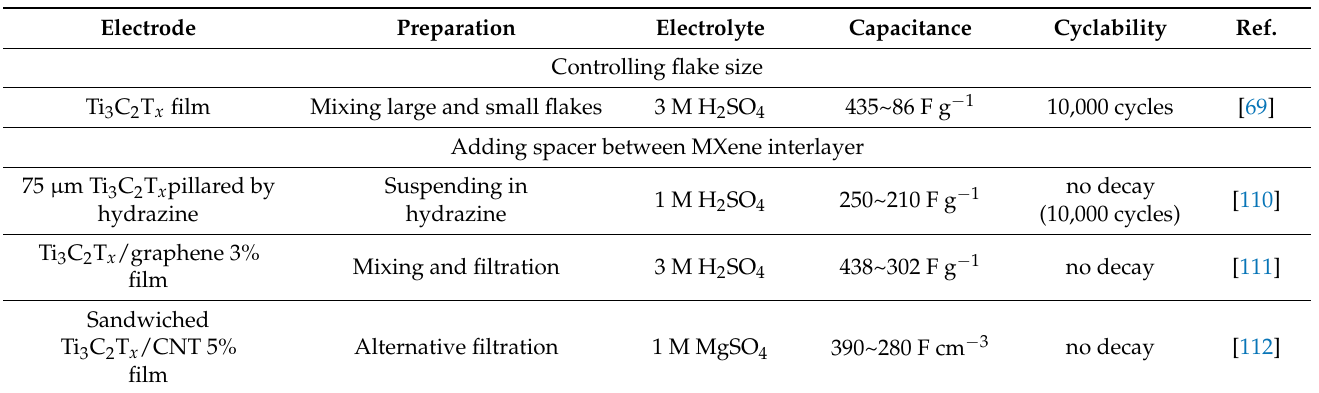
Figure 15. Schematic illustration of multifunctional RGO/Ti 3 C 2 T x MXene fabrics, and electrochem- ical performance of the MCF and RMC fabrics. ( a ) CV curves of the MCF and RMC at 10 mV s − 1 . Areal specific capacitance ( b ) and gravimetric specific capacitance ( c ) of MCF and RMC. ( d ) Areal and gravimetric specific capacitance of RMC compared with the reported MXene-modified fibers, yarns, and fabrics. ( e ) Nyquist plots of MCF and RMC. ( f ) Four RMC-4 supercapacitors connected in series as a wristband to power a watch. ( g , h ) SEM images of fabrics [109]. Table 2. Capacitive outcome of MXene electrodes with optimized structural design.